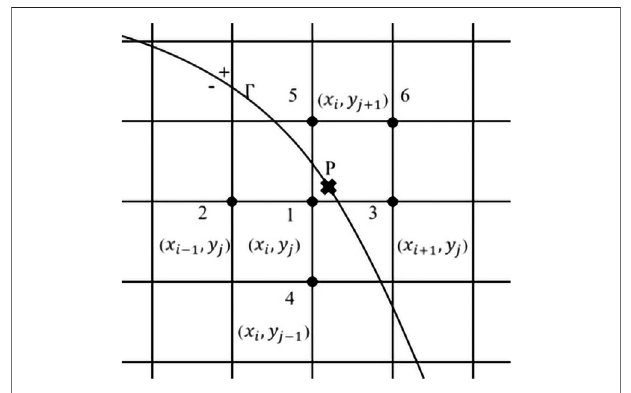
FIGURE 3 | Selection of six points in the modi fi ed six-point method. Select the Euler point 1closest to theLagrange point (P), and thesixthpoint is the Euler point closest to the Lagrange point (P) except points 1 to 5.